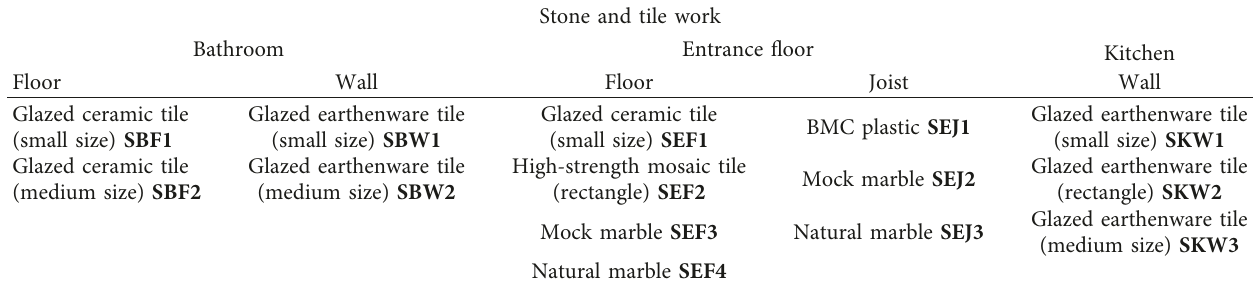
Table 5: Combination matrix (stone and tile work).